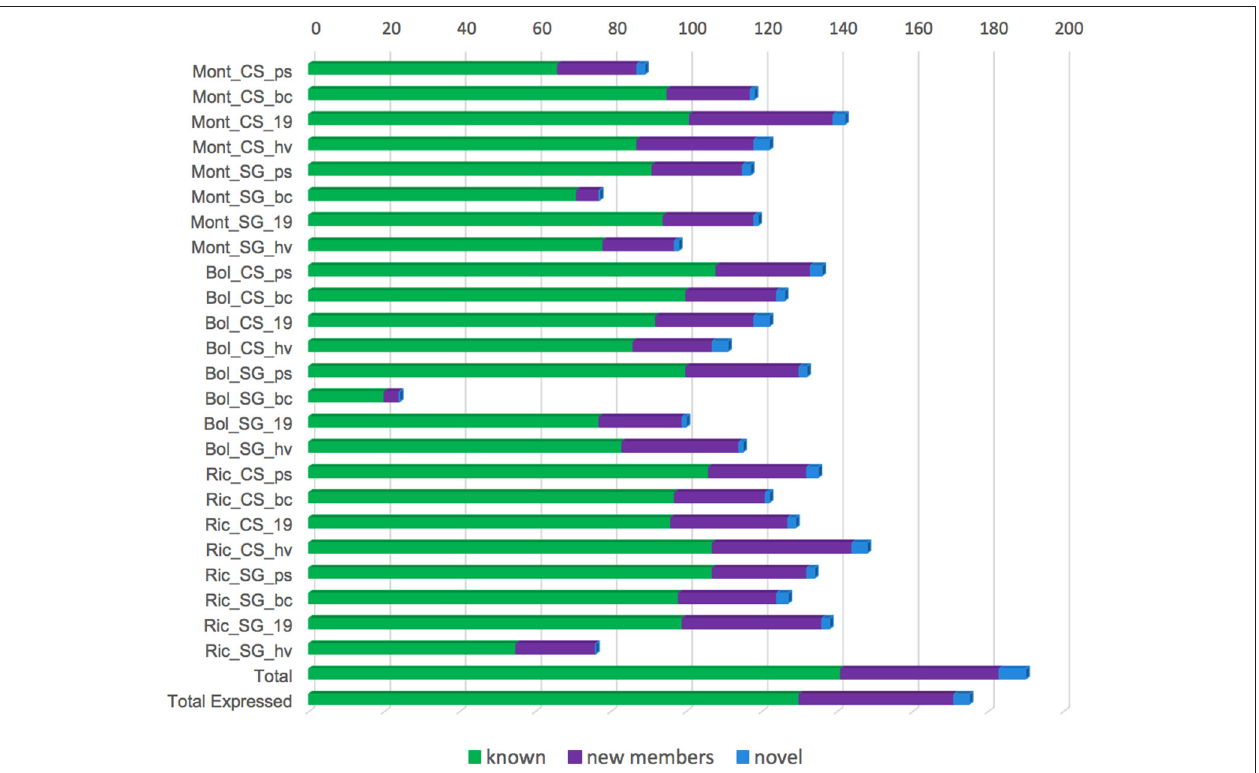
FIGURE 7 | Number of miRNA expressed in each small RNA library constructed using berries of 2 grapevine cultivars [Cabernet Sauvignon (CS) and Sangiovese (SG)], collected in 4 different developmental stages [pea size (ps), bunch closure (bc), 19 ◦ Brix (19), harvest (hv)] and 3 vineyards [Montalcino (Mont), Bolgheri (Bol), Riccione (Ric)]. “ Total” refers to the total number of miRNAs, comprising known, novel and their complementary molecules identified in our data. “ Total expressed” refers to the number of miRNAs expressed in at least one library. Library codes are found in Table 1